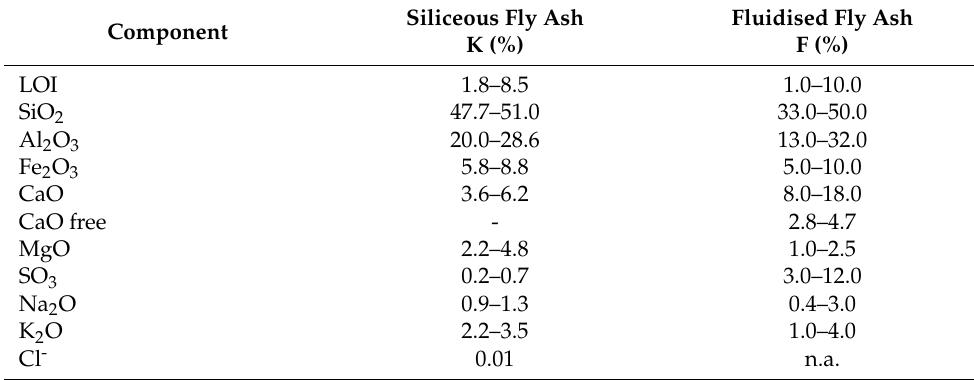
Table 1. Chemical—of ashes from Polish thermal power plants